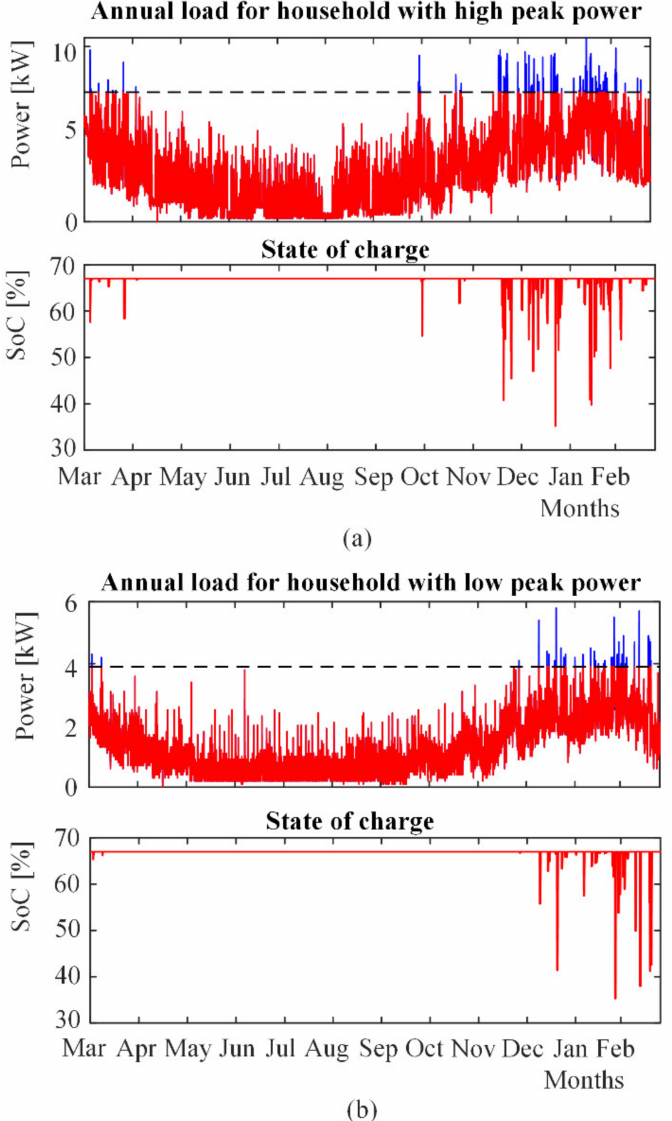
Figure 18. Peak-shaving for a double power peaks by using distributed BESS in case of household for ( a ) high power peak and ( b ) low power